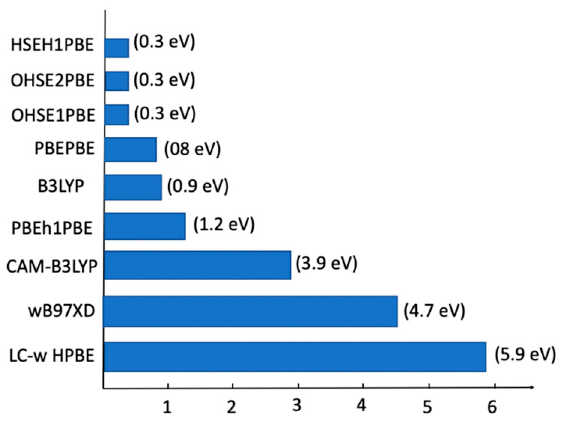
100Oe T B Figure 11. ZFC/FC curves. 2.6. TD-DFT Study Despite the difficult performance of benchmarks for this kind of systems, especially due to the requested resources, TD-DFT methods have become useful tools used by theo- rists and experiments to examine, understand, and predict the optical and chemical be- havior of different types of organic and inorganic compounds [43–46] due to the remark- able ratio of accuracy and computational time. As mentioned above, we have used nine density functionals to investigate the optical and chemical behavior of the studied compound. In the first step, we focused on the evaluation of different functional performance by the comparison of calculated energy gap (Eg) with the experimental value (3.6 eV). As we see in Figure 12, the B3LYP, CAM-B3LYP, LC-wHPBE and wB97XD function- als fail to recover the correct Eg. This is mainly due to the weak bonds of water molecules. For the five functionals employing PBE correlation, PBE1PBE underestimates the Eg by 0.8 eV while PBEh1PBE overestimates it by 1.2 eV. However, the OHSE1PBE,